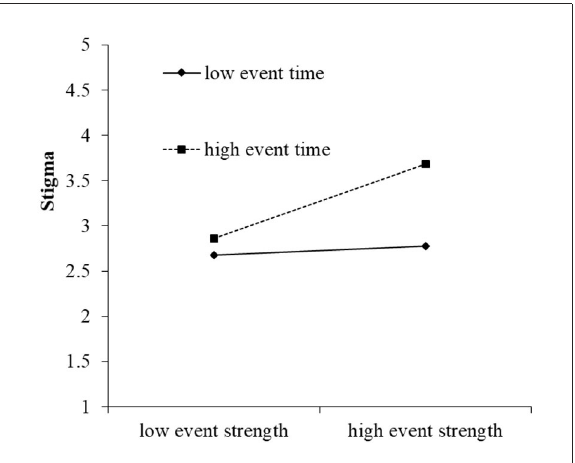
FIGURE5 The moderating effect diagram of event time between event strength and